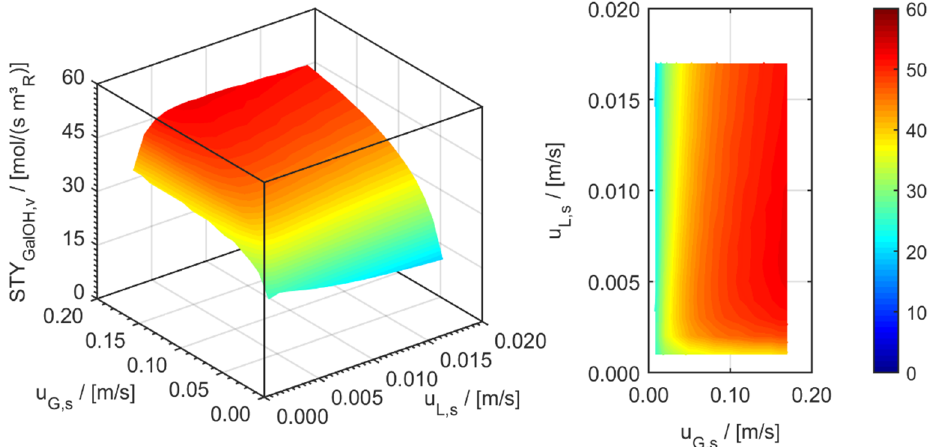
Figure 14. Volumetric space-time yield referring to galactitol in foam-packed minichannel reactors operating at different gas and liquid superficial velocities.